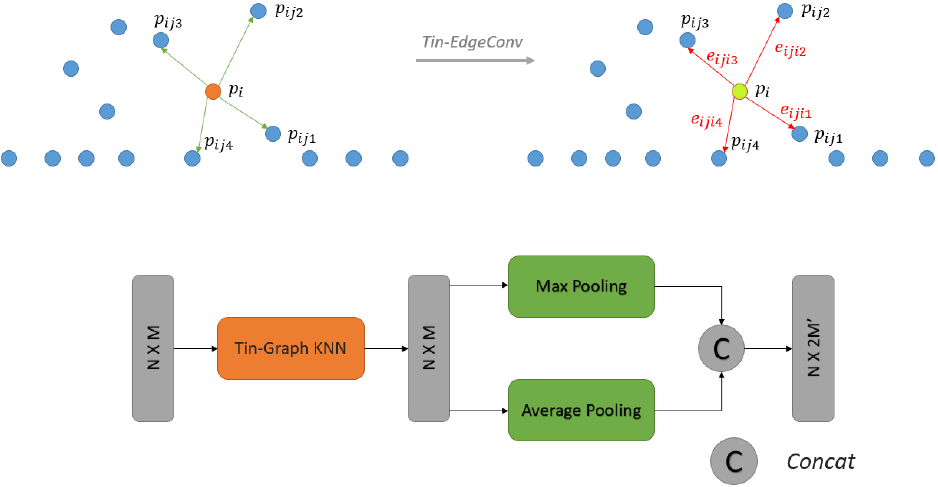
Figure 4. Top: Visualization of Tin-EdgeConv operation; bottom: Tin-EdgeConv structure.